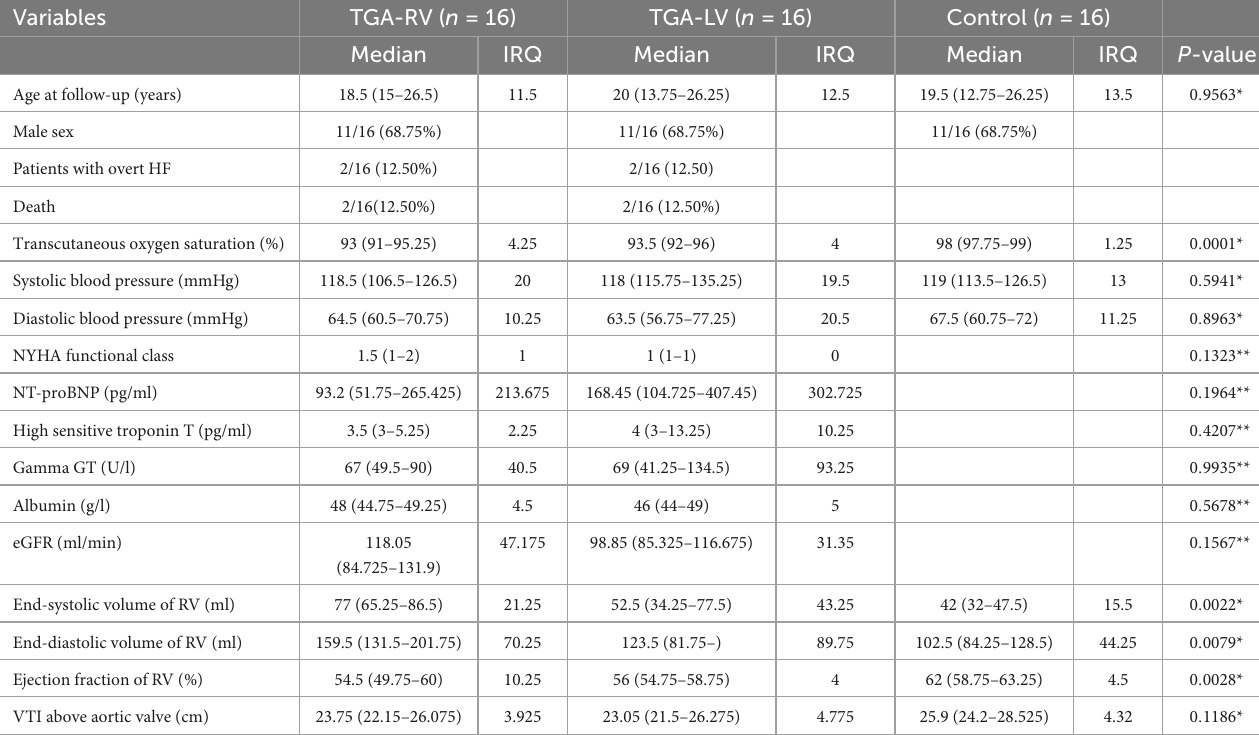
TABLE 1 Characteristics of enrolled controls and TGA